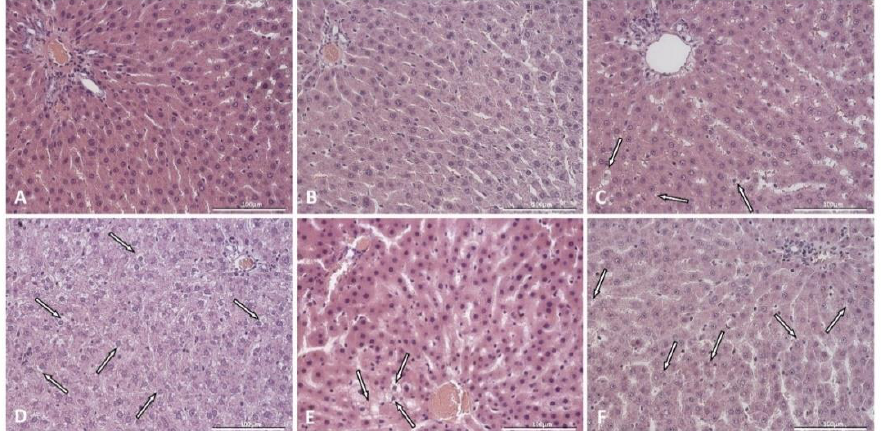
Figure 2. Liver sections from a representative rat from each group: ( A ): control; ( B ): control supple- mented with TT saponins; ( C ): control supplemented with TT saponins plus inulin; ( D ): with induced diabetes mellitus; ( E ): with induced diabetes mellitus supplemented with TT saponins; ( F ): with induced diabetes mellitus supplemented with TT saponins plus inulin. Arrows indicate steatosis. H-E × 40. Scale bar: 100 µm.